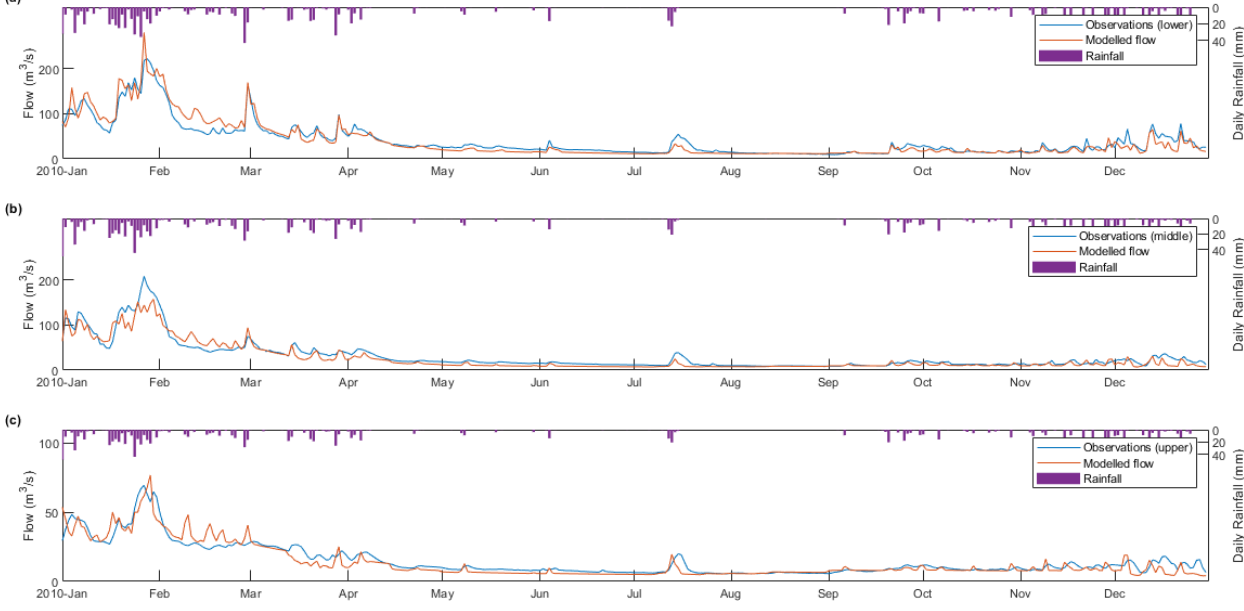
Figure 6. Daily modeled flow, observed flow, and rainfall in the (a) lower, (b) middle, and (c) upper basin in the year 2010 using TOP- MODEL.